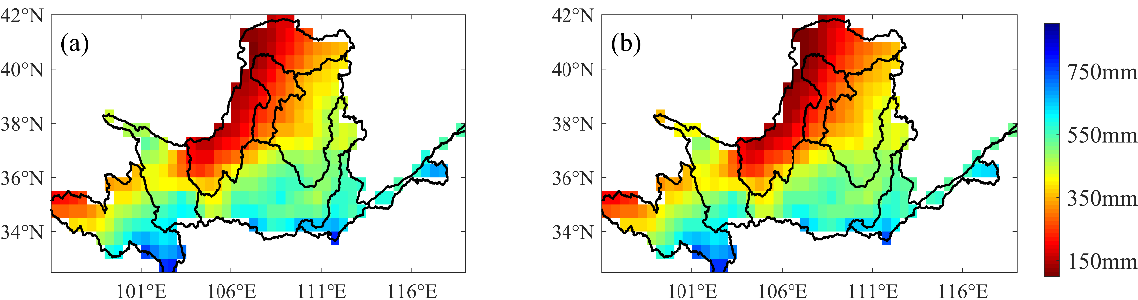
Figure 3. Spatial distribution of average annual precipitation from observation and model simulation after bias correction during the historical period (1961–2014) over Yellow River Basin. ( a ) Observation and ( b ) after the bias correction.